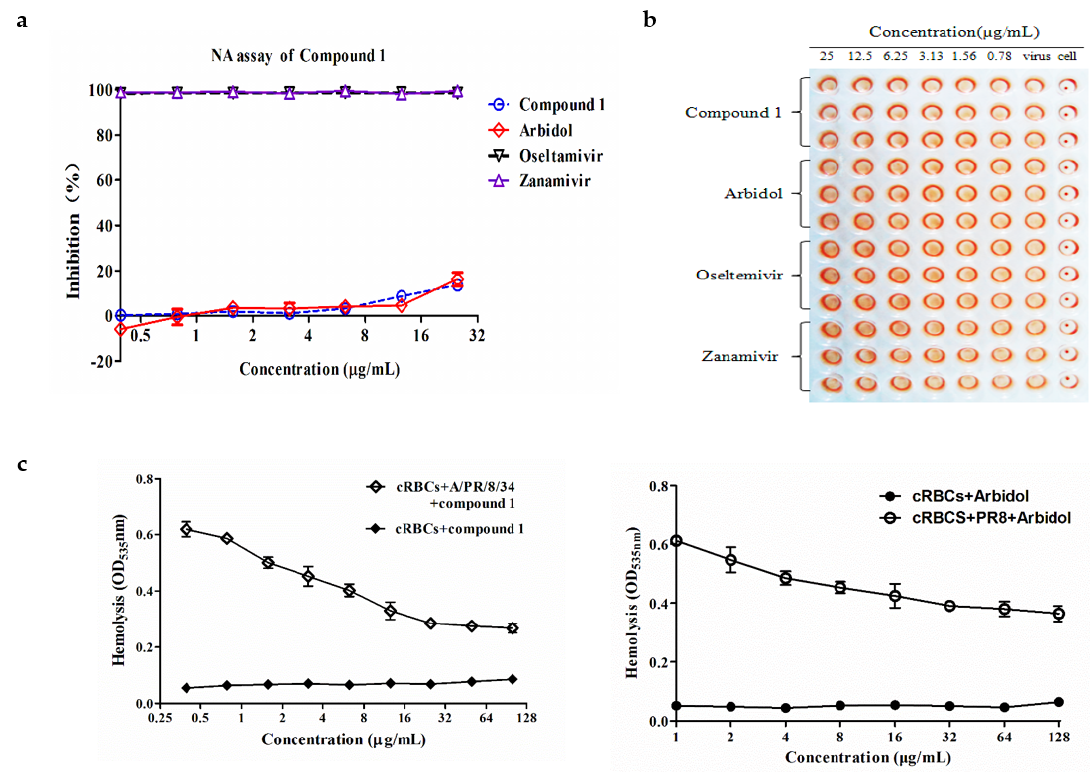
Figure 4. ( a ) Neuraminidase (NA) inhibition assay. ( b ) The hemagglutination inhibition (HI) assay of compound 1 . ( c ) Inhibition assay of HA-mediated hemolysis of chicken